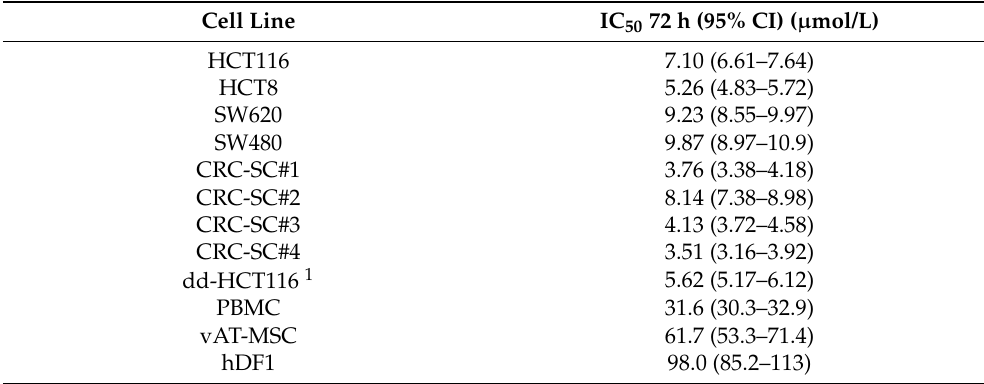
Table 3. Summary of spiperone IC 50 values measured by viability assay in different cell